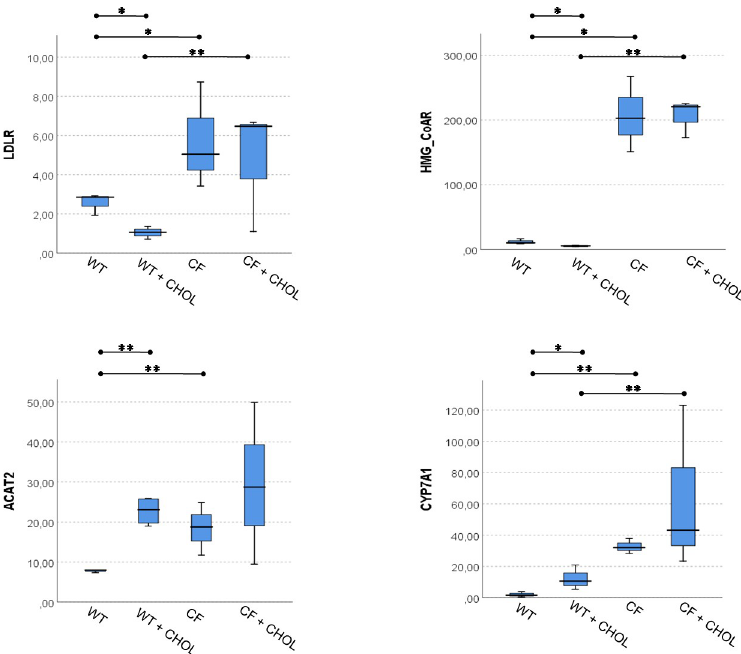
Fig 3. Multiple comparison among WT and CF with and without cholesterol supplementation for liver mRNA expression levels of LDLR , HMG-CoAR , ACAT2 and CYP7A1 . The significance of Kruskal-Wallis test for all variables was < 0.0001. Mann–Whitney U post hoc test: � p < 0.05, �� p <